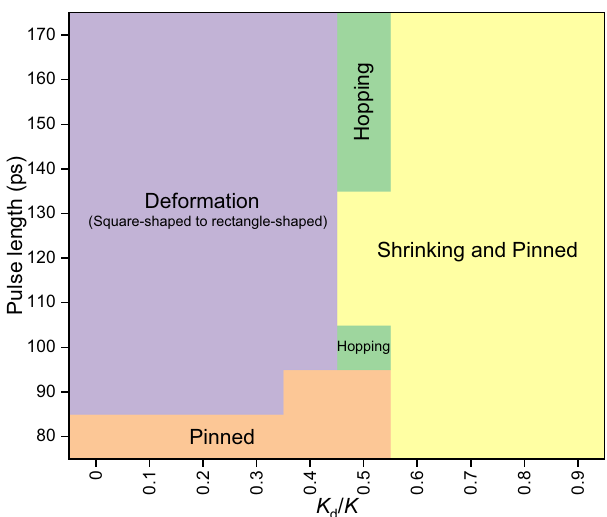
Fig. 6 A basic phase diagram of the system transitions from single skyrmion hopping to the skyrmion deformation. Deformation means the square-shaped skyrmion is deformed to a rectangle-shaped skyrmion after the pulse application. Hopping means the square-shaped skyrmion hops from the grid cell at the sample center to the right nearest-neighboring grid cell after the pulse application. Pinned means the square-shaped skyrmion is pinned by the grid cell at the sample center during and after the pulse application. Shrinking and pinned means the square-shaped skyrmion shrinks to a smaller round-shaped skyrmion and is pinned on the defect line after the pulse application. Here, l = 30 nm, w = 4 nm, n = 11, and the damping parameter α = 0.3. l denotes the spacing between two adjacent parallel defect lines. w denotes the width of the defect line. n denotes the number of unit square patterns along the x and y directions. The side length of the sample equals 378 nm. A square-shaped skyrmion with the topological charge of Q = 1 is relaxed at the sample center as the initial state at t = 0 ps. A current pulse of j = 100 MA cm − 2 and p ¼ (cid:2) ^ y is applied, and then the system is relaxed until t = 1000 ps. The fi nal states are con fi rmed at t = 1000